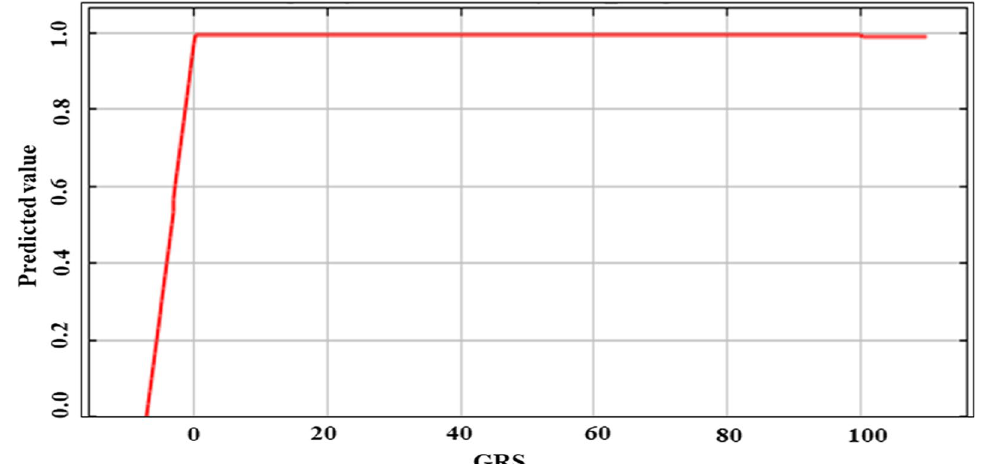
Fig. 10 Receiver operating characteristics curve (ROC) illustrating relationship between probability of occurrence of suitable conditions for distribution of C. wightii with most significant land use predictor GRS (percent share of